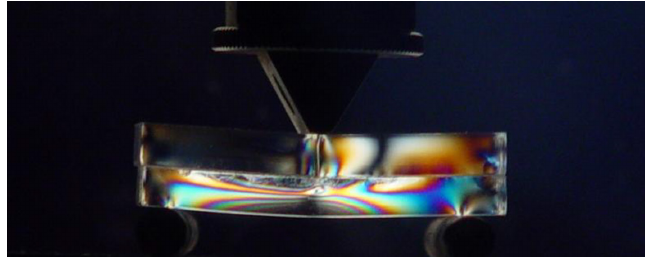
Fig. 5 Example of isocline on a prism made of plexiglass (photoelastic stress test by Elena